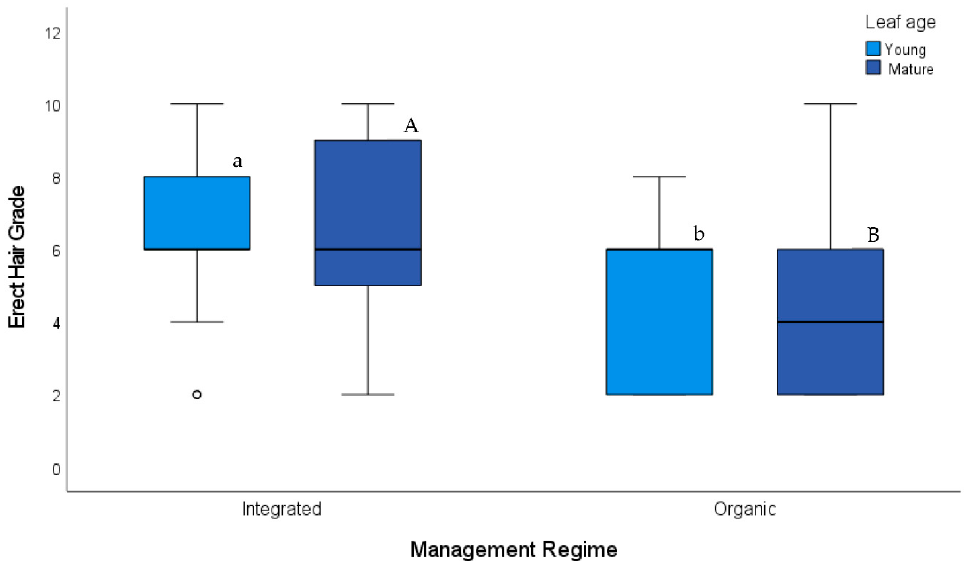
Figure 1. Variety-dependent erect hair grades (representing the sum of grades on the blade and main veins) of the leaf underside in vineyards under integrated and organic pest management regimes sampled by [1]. Thick horizontal lines represent the median, boxes represent the interquartile (IQ) range, whiskers are 1.5 times the IQ range, symbols depict the outliers. Different small and capital letters on top of boxes indicate significant differences in leaf hairiness of sampled vineyards under integrated and organic pest management ( n = 16 for each pest management regime and leaf age category; Mann–Whitney U-tests p < 0.05). Table 1. Results of generalized linear models (GLM; normal distribution, identity link) on phytoseiid, tydeid and eriophyid mite abundance per 100 cm 2 leaf area and pollen deposition per 1 cm 2 leaf